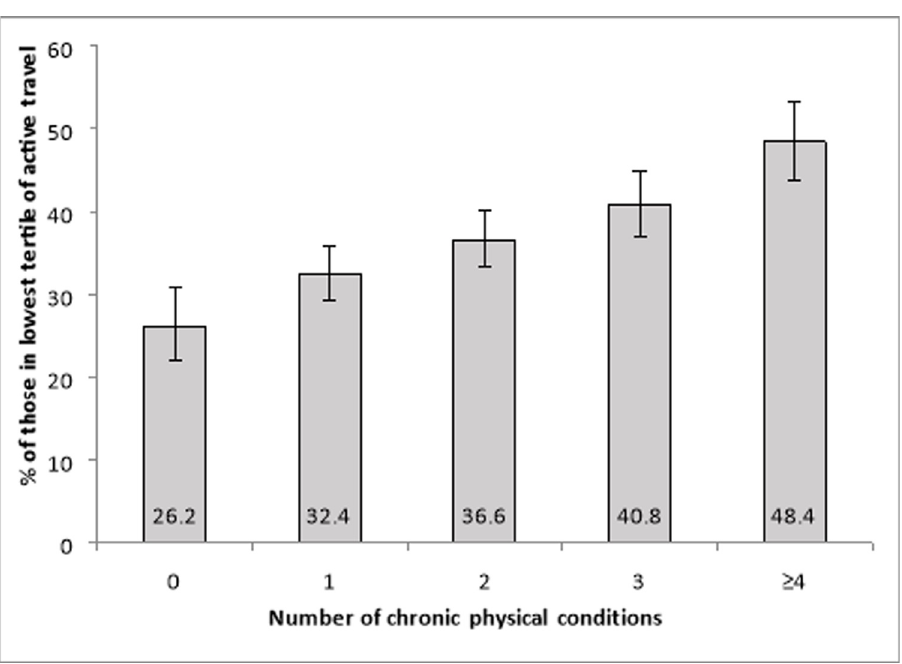
Fig 2. Prevalence of lowest tertile of active travel by number of chronic physical conditions. Bars denote 95% confidence intervals.